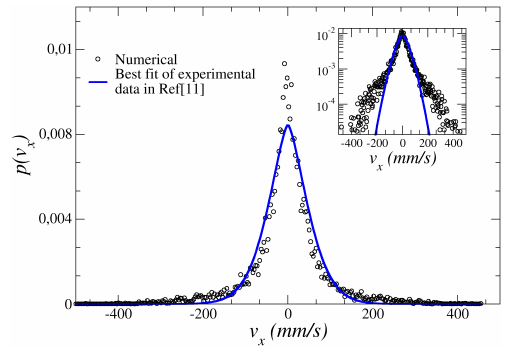
Figure 3. Speed distribution p ( v x ) in the x direction (two moving walls), obtained for A = 1mm and f = 30Hz. The inset shows the same but in semi-log scale. In both cases, the best fit of the experimental data Ref[11] is also shown for comparison.